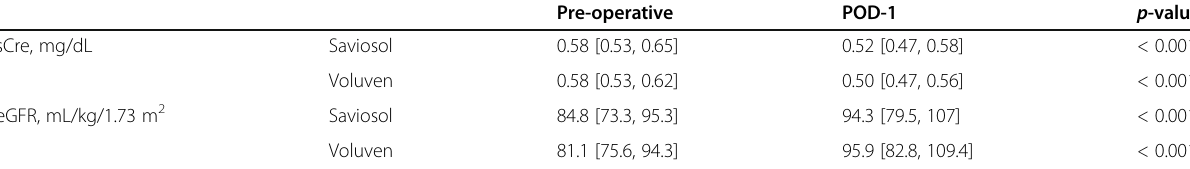
Table 3 Changes in renal function from before surgery to POD-1